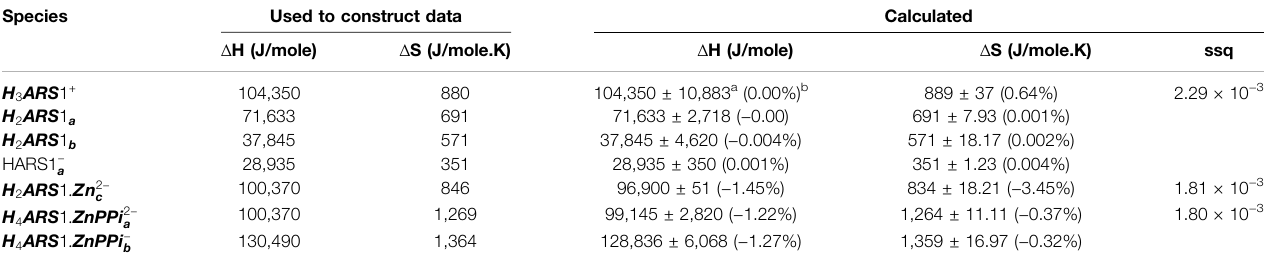
TABLE 6 | Obtained af fi nity thermodynamic constants for the simulated pH datasets corresponding to binding af fi nities of ARS, 1 , Zn, and PPi. Used to construct data CalculatedSpecies Δ H (J/mole) Δ S